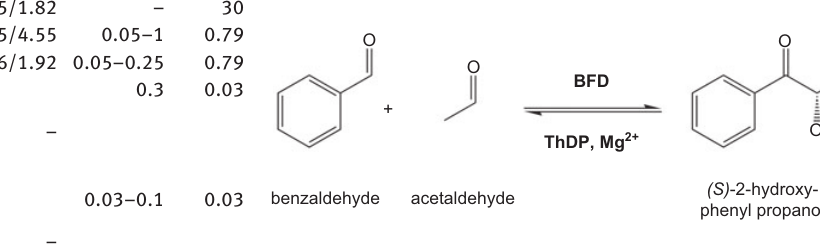
Figure 7 Reaction scheme for the ligation of benzaldehyde (BA) and acetaldehyde (AA) catalyzed by the enzyme benzoyl formate decar- boxylase (BFD). Reaction conditions: 40 m m BA, 400 m m AA, 100